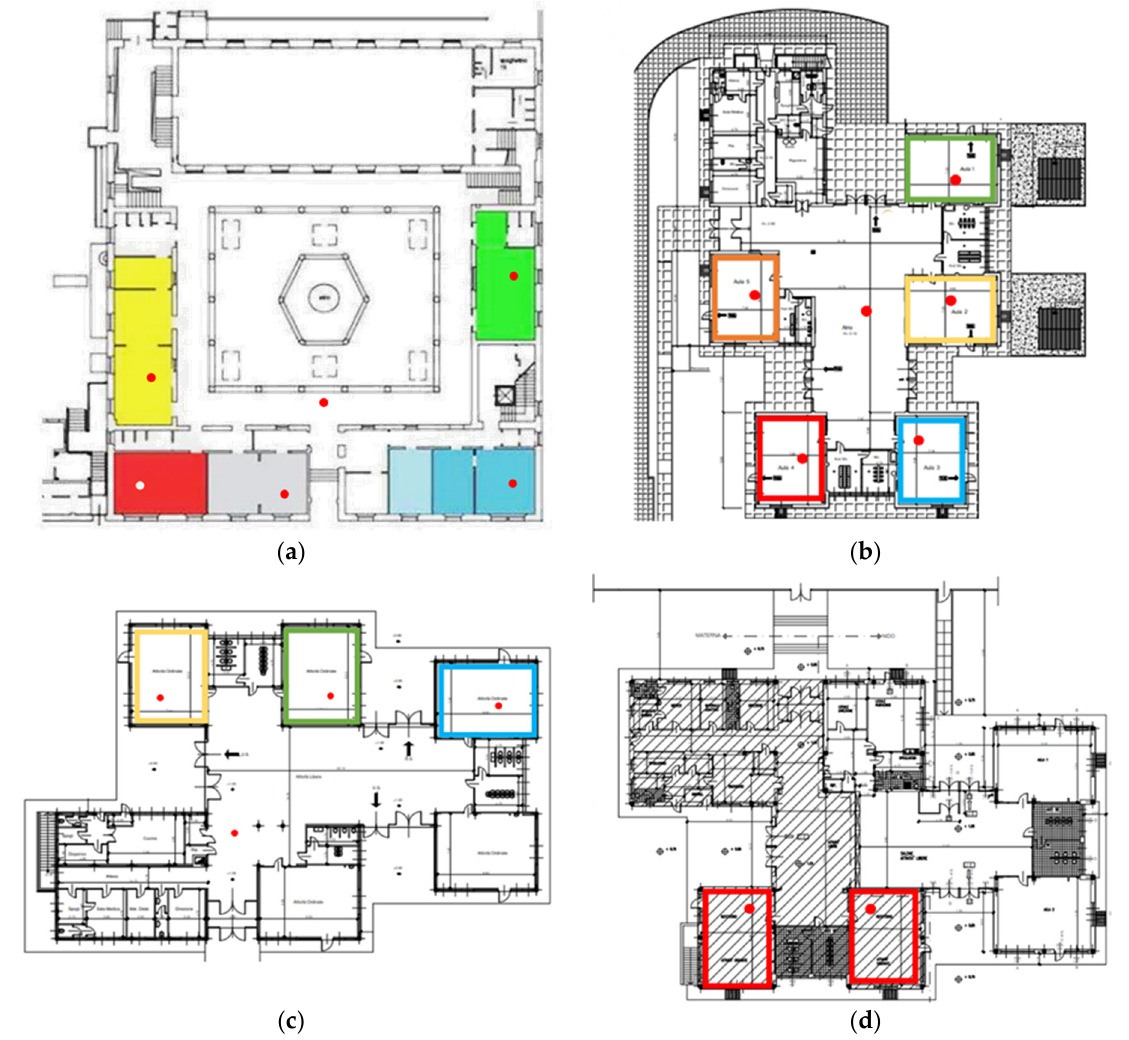
Figure 2. ( a ) Ground floor of Immacolata building; ( b ) Marx building; ( c ) Airaghi building; ( d ) Lamennais